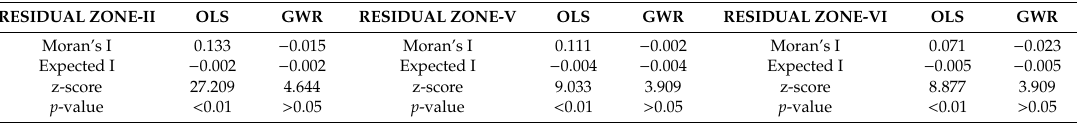
* Indicates that the coe ffi cients vary significantly throughout the space (geographically variability test). Table 12. Moran’s I spatial autocorrelation for both OLS and GWR residuals at the three zones: Zone II in the northern Montaña region, zone V in the Media region, and zone VI in the Ribera Alta Southern region. GWR: geographically weighted regression and OLS: ordinary least